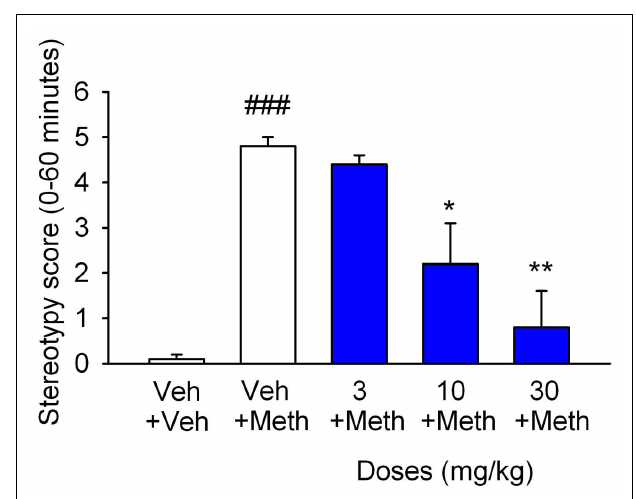
FIGURE 7 | CyPPA counteracts methylphenidate-induced stereotypies in mice. Effects of CyPPA on methylphenidate (METH)-induced stereotypy. Data are expressed as mean total gnawing score + SEM. Mice were dosed (i.p.) with vehicle or CyPPA (3, 10, and 30mg/kg) 15min before administration of METH (40mg/kg, s.c.) or saline, respectively (blue bars). ### P < 0.001 versus vehicle treated group, # P < 0.05, *** P < 0.001 versus METH treated group (one-way ANOVA followed byTukey’s multiple comparison test, n =